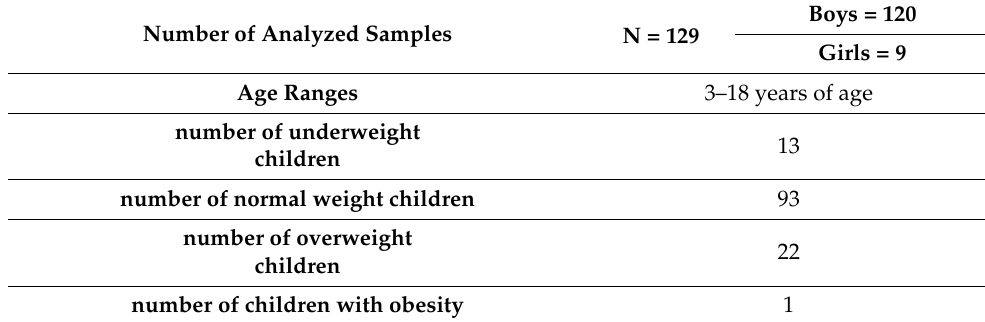
Table 3. Characteristics of studied population.